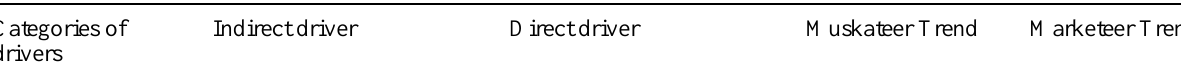
Table 4. Trends of principal drivers affecting working and living in European rural regions under two contrasting